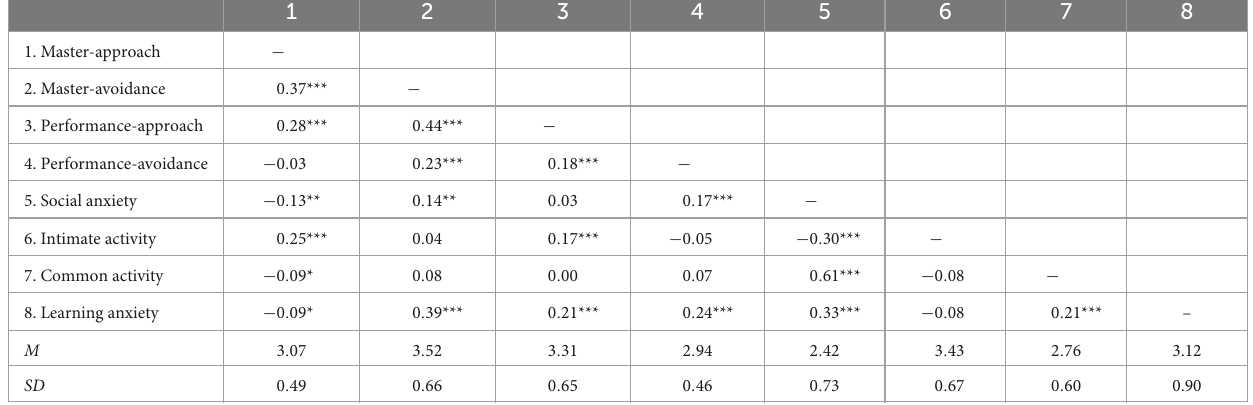
TABLE 1 Descriptive statistics and correlations for achievement approach, peer interaction, and learning